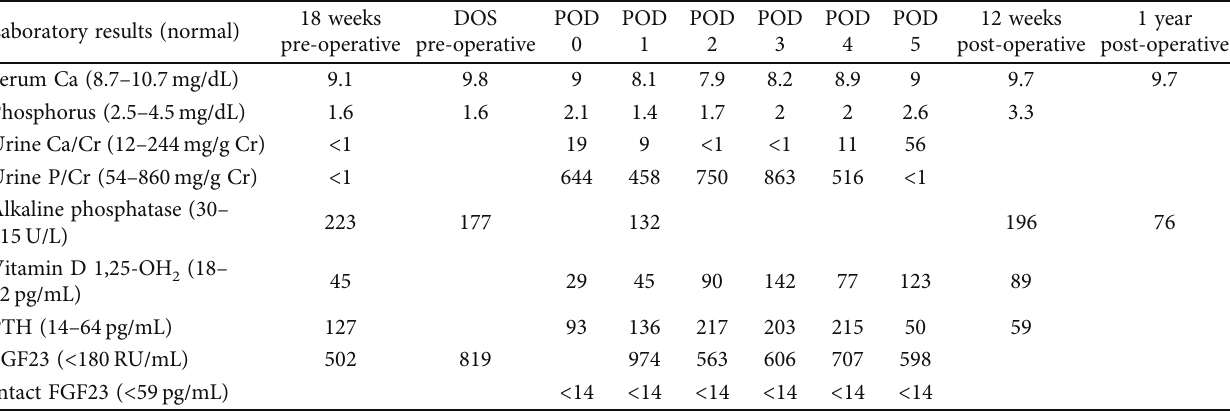
Table 1: Pre- and post-operative blood and urine laboratory values for Case 2. Excess FGF23 produced by a PMT promotes renal phosphate -Vitamin D), leading to renal phosphate wasting, hypophosphatemia, excretion and suppresses the production of active vitamin D (1,25-OH 2 elevated alkaline phosphatase, and secondary hyperparathyroidism. The rapid fall in intact FGF23 after tumor removal induces a rebound in -Vitamin D production and increased calcium requirements as the skeleton begins to remineralize. Concurrently, renal phosphate 1,25-OH 2 excretion decreases, and blood phosphate levels return to normal [17].